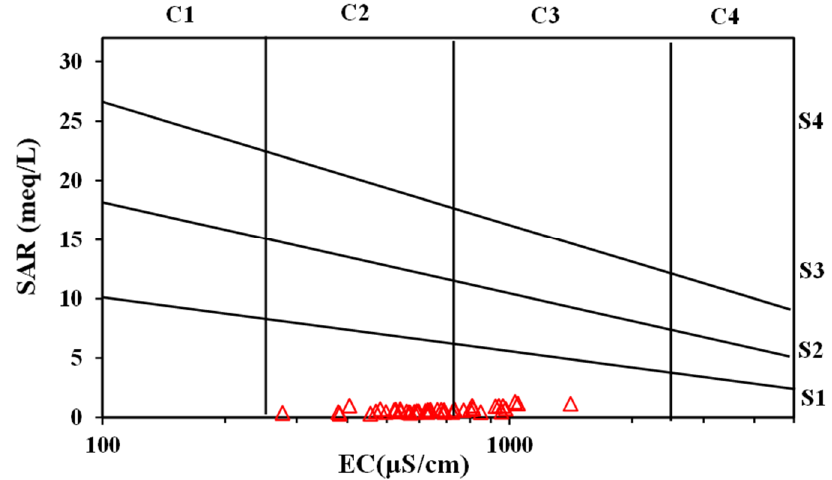
Figure 11. Salinity diagram showing the distribution of irrigation waters.